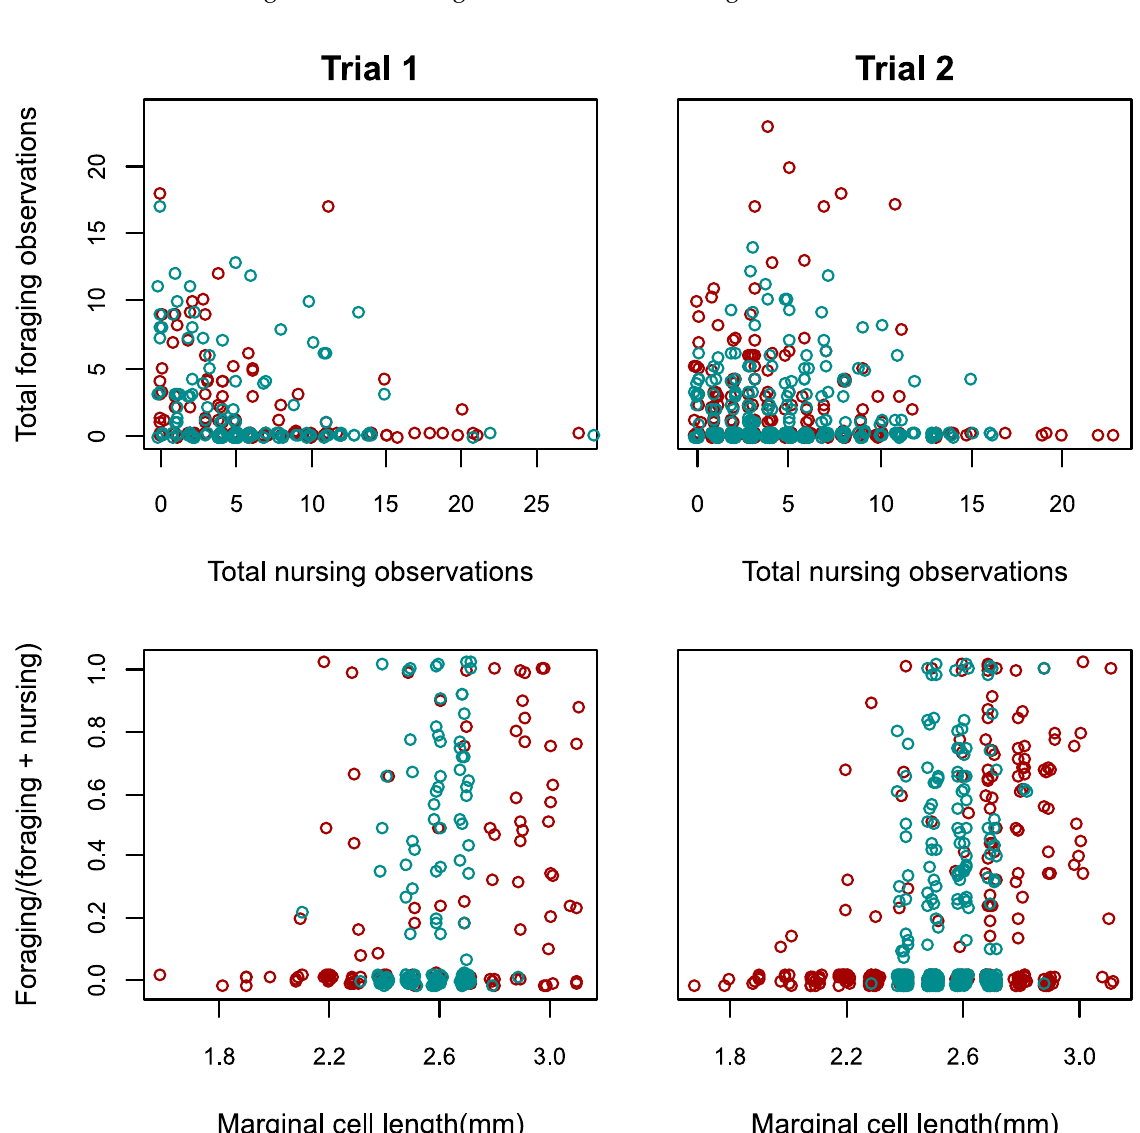
Figure 4. Nursing and foraging performance in size–diverse and -homogenous colonies. Red symbols—individuals in diverse colonies; blue symbols—individuals in homogeneous colonies. Trial 1—left column; Trial 2—right column. Upper row: the relationship between total foraging and nursing (brood tending) observations per worker. Lower row: foraging: nursing ratio as a function of worker body size (wing marginal cell length). In order to display multiple data points in the same position, a small amount of horizontal and vertical random noise has been added to each data point.